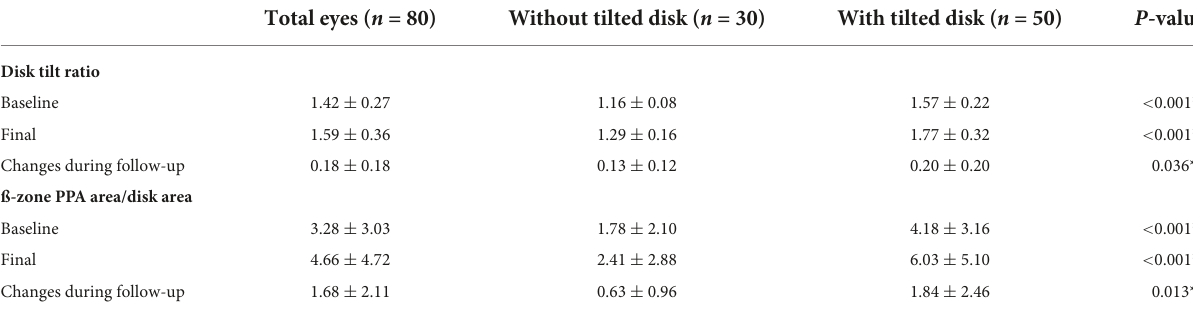
TABLE 3 Optic disk features and changes during follow-up according to the presence of optic disk